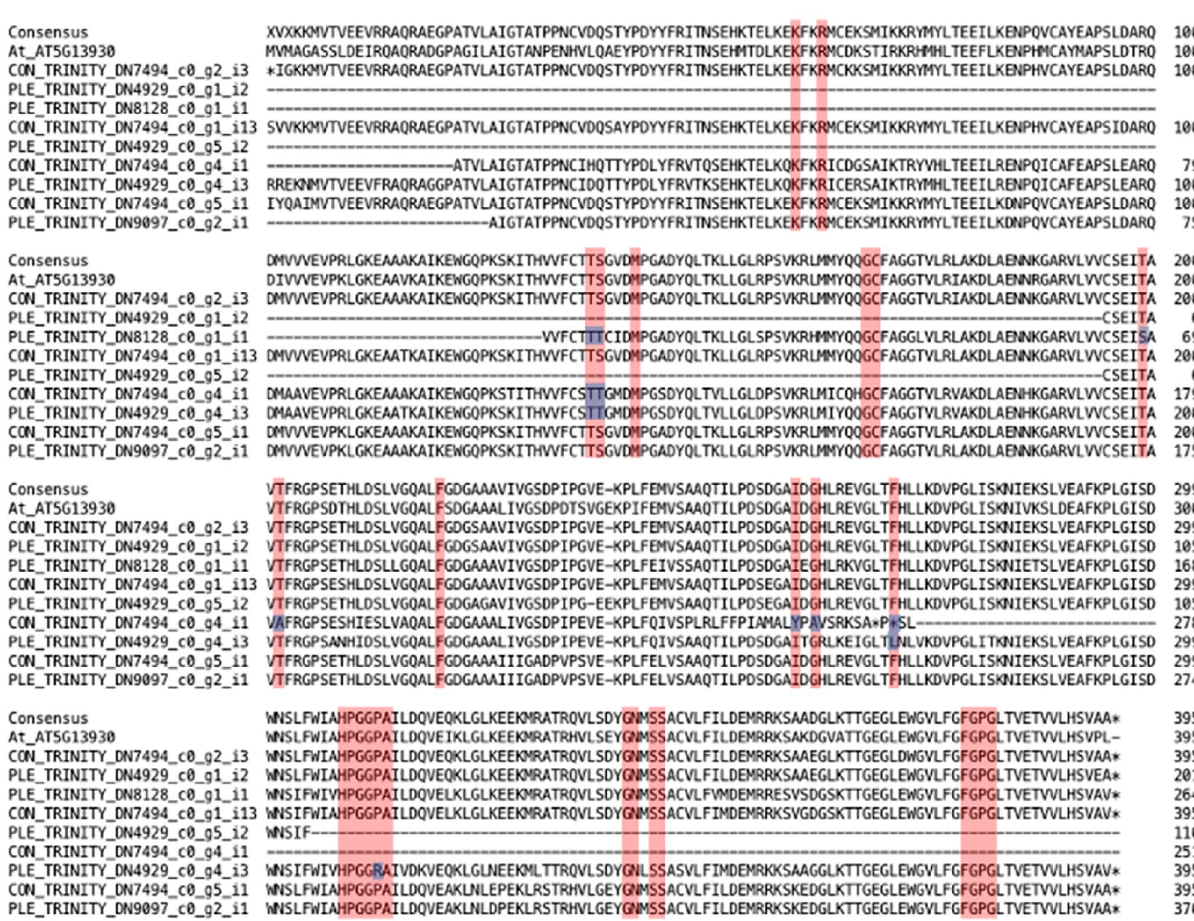
Figure 6. Multiple sequence alignment of CHS copies from B. conchifolia , B. plebeja and A. thaliana . Residues highlighted in red correspond to conserved sites obtained from the literature. Residues highlighted in blue are sites which differ in at least one Begonia sequence.